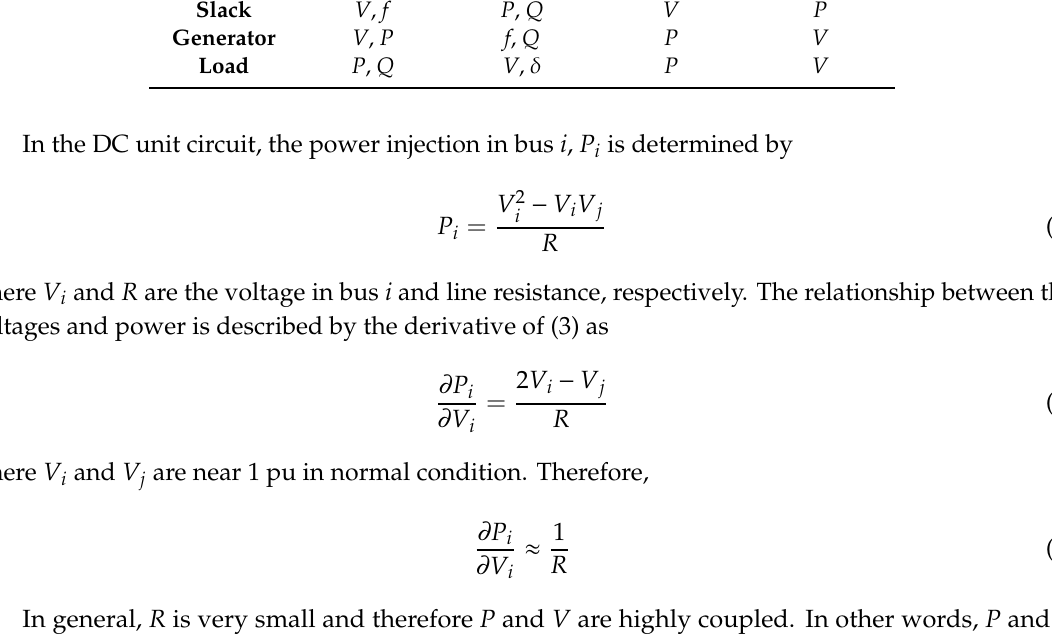
Table 1. AC and DC state variables determined by the device or given from the system